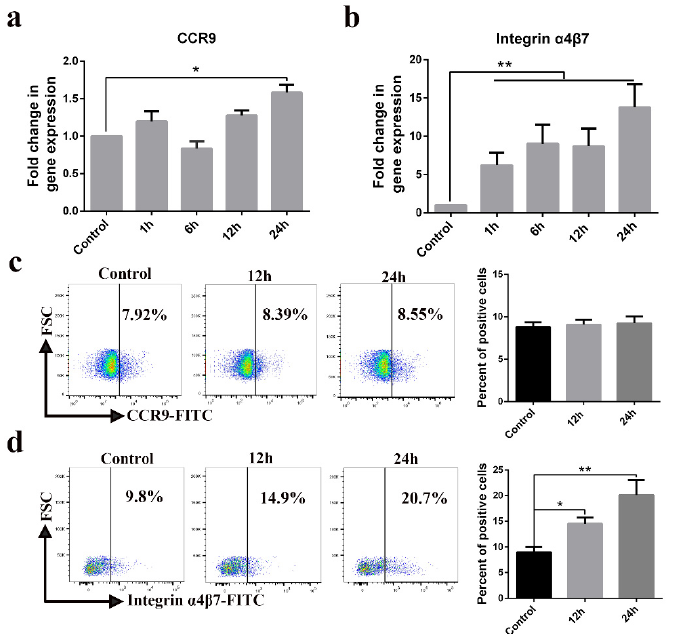
Figure 7. CD3 + T cell homing receptor integrin α 4 β 7 is upregulated by PEDV infection. ( a , b ) The expression levels of CCR9 and integrin α 4 β 7 were examined in CD3 + T cells infected with PEDV at indicated times using real-time RT-PCR. ( c , d ) The expression levels of CCR9 and integrin α 4 β 7 were examined in CD3 + T cells infected with PEDV at the indicated time using FACS. Data are the means ± SDs. Statistical significance was assessed using one-way ANOVA. Note: * p < 0.05; ** p < 0.01. CCR9: C-C chemokine receptor.